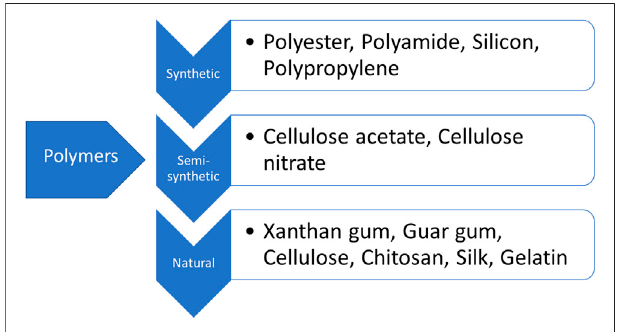
FIGURE 1 | Types of polymers based on their